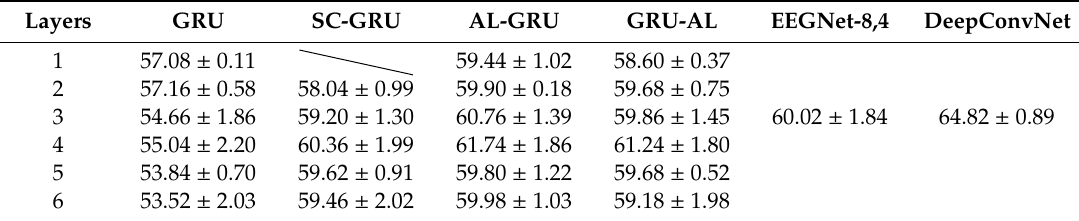
Table 2. Accuracies of models with di ff erent number of layers